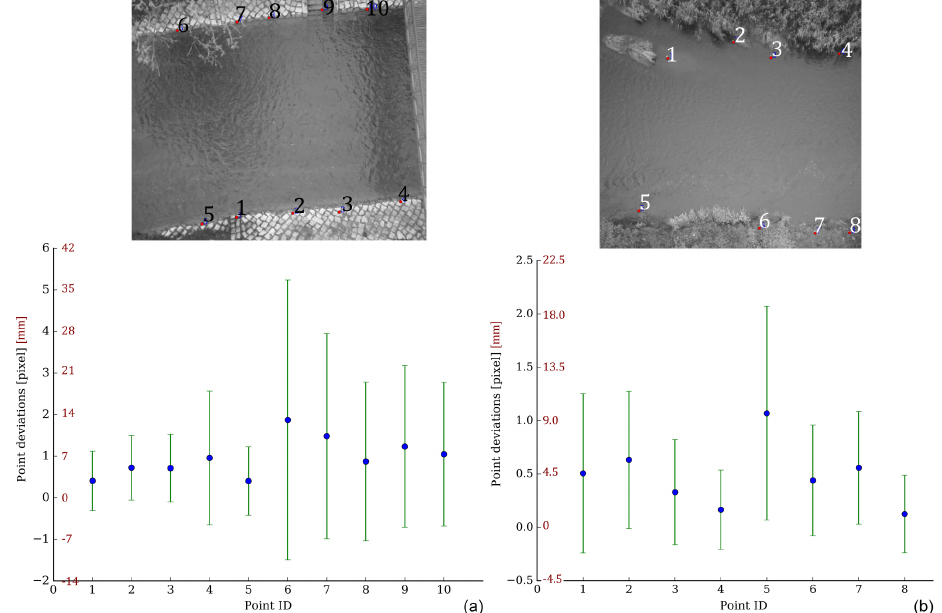
Figure 6. Accuracy of co-registration of video frames to single master frame displayed in image space (black axis) and the corresponding accuracy in object space (red axis) at the river Wesenitz (a) and Freiberger Mulde (b) . Note that the images are only extracts from the original (bigger)